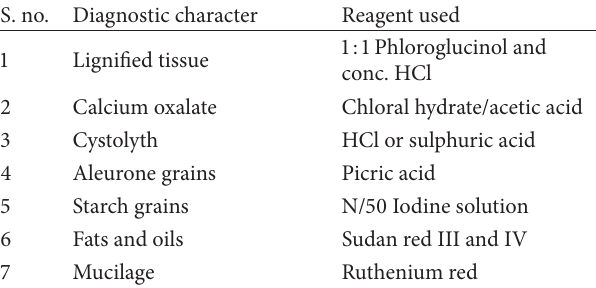
Figure 1: Dorsal and ventral view of Memecylon umbellatum leaves. Table 1: Reagents used for microscopical observations.